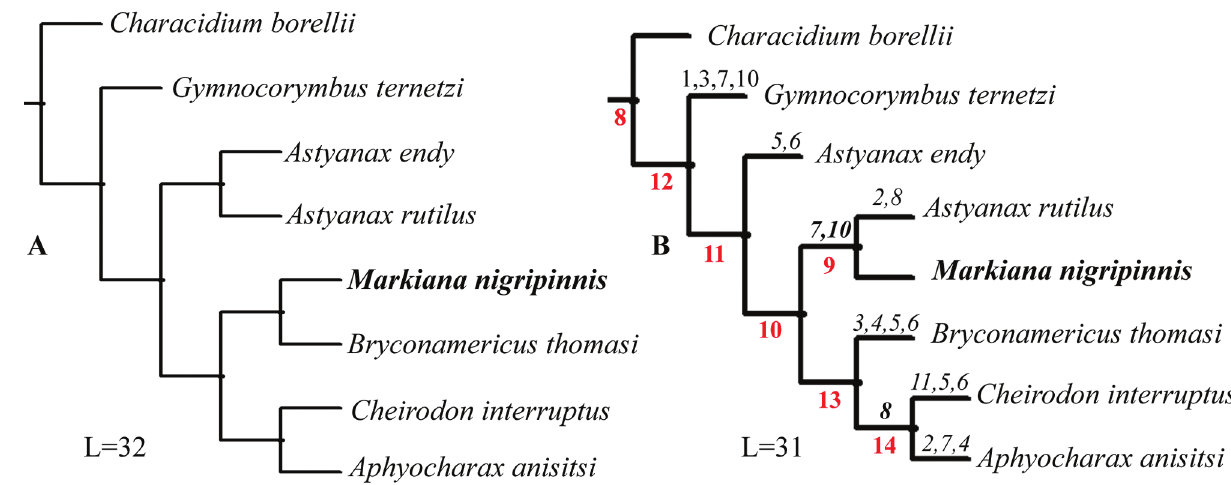
Fig. 7. Phylogenetic relationship of the selected species after Mirande (2009, 2010) final hypothesis of phylogenetic relationships. A) Considering Markiana nigripinnis as a member of Stevardiinae sensu Oliveira et al . (2011) and Baicere-Silva et al . (2011) and B) with M. nigripinnis as a member of Astyanax clade sensu Mirande. Synapomorphies and autapomorphies obtained from optimization of the characters proposed herein are presented in italics above branches as character number. Node numbers are presented in red below